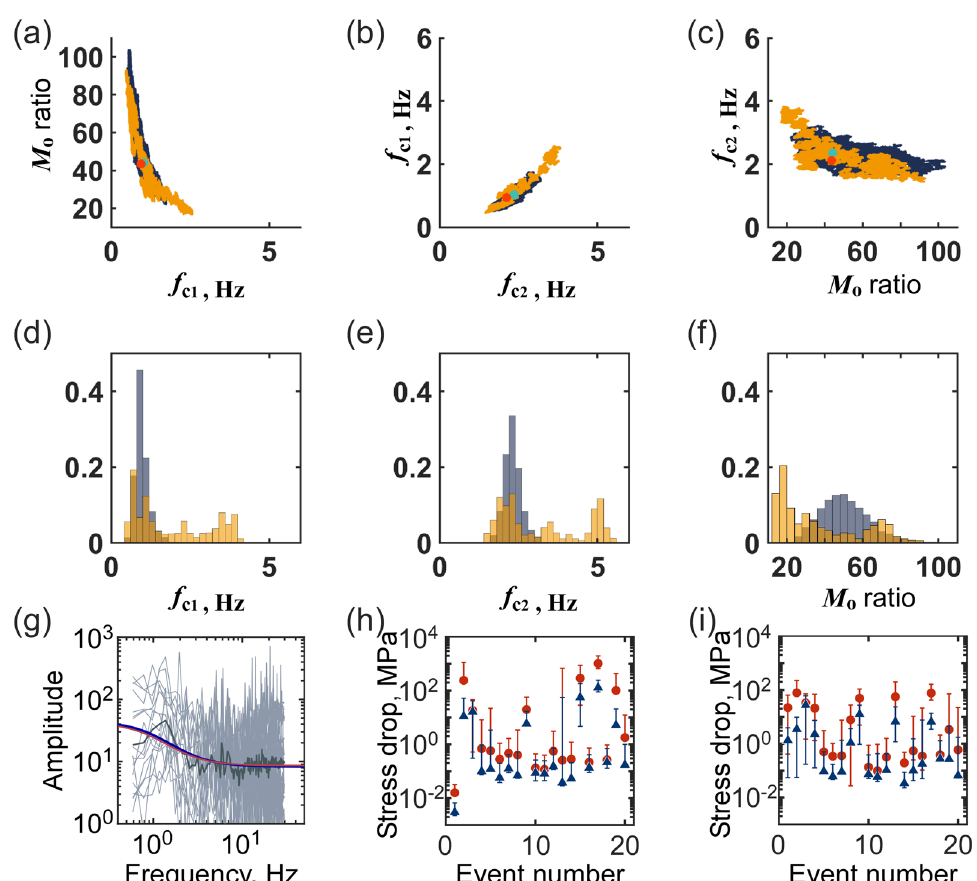
Fig. 5 Source parameters calculated from observational data subjected to 400,000 iterations of MCMC analysis. a Sampling distribution projected onto a 2D plane. Relationships between moment ratio and f c 1 , b f c 1 and f c 2 , and c moment ratio and f c 2 . The dark blue areas indicate results assuming an F -distribution, and the yellow areas indicate results assuming a normal distribution. Cyan and orange circle indicate the highest likelihood values from the F - and normal distribution calculations, respectively. d Histogram of the sampling in f c 1 , e f c 2 , and f moment ratio. g Spectral ratios of the 7th event in Table 1. Gray, black, and red curves, respectively, indicate spectral ratios for each seismic station, an average of all spectral ratios, and the theoretical spectral ratio according to the highest likelihood values. h Estimated stress drops for 20 events in a cluster assuming an F -distribution. Red circles indicate results obtained from large earthquakes, and blue triangles indicate results obtained from the smaller earthquake. The thin bars indicate a 95% confidence interval obtained from the variation of the accepted sampling. i Estimated stress drops assuming a normal distribution. Red circles indicate results obtained from large earthquakes, and blue triangles indicate results obtained from smaller earthquakes.